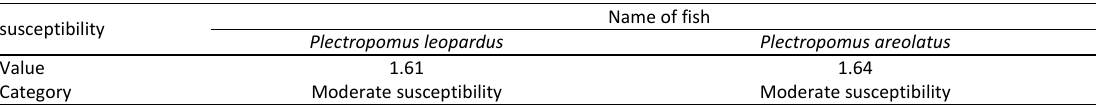
Fig. 5: The results of the susceptibility and productivity analysis of red and black groupers.